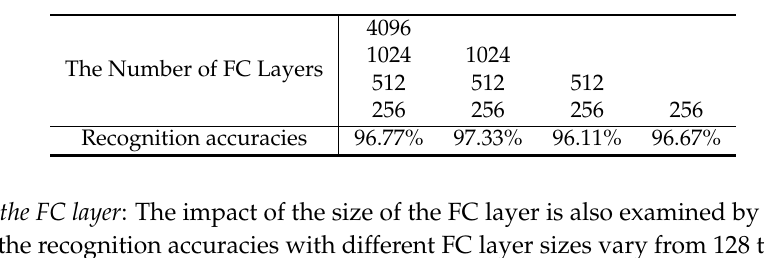
Table 5. Recognition accuracies vs. Number of FC layers.